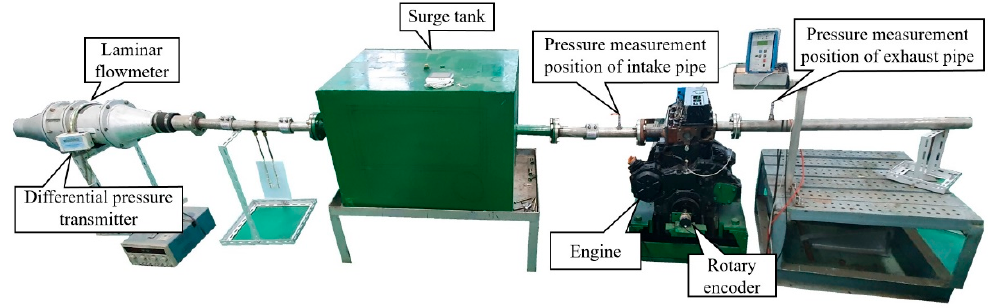
Figure 1. Photograph of the experimental apparatus. Table 1. Specifications of the experimental apparatus.